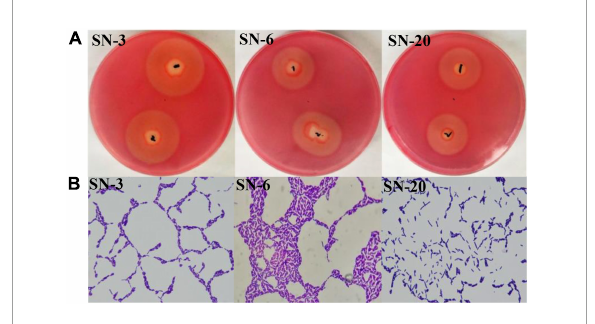
FIGURE1 Isolation and identification of cellulolytic bacteria. (A) Diameter of hydrolysis circle. 1 and 2 represent the same strain. (B) Gram staining of strains (1,000 × ).